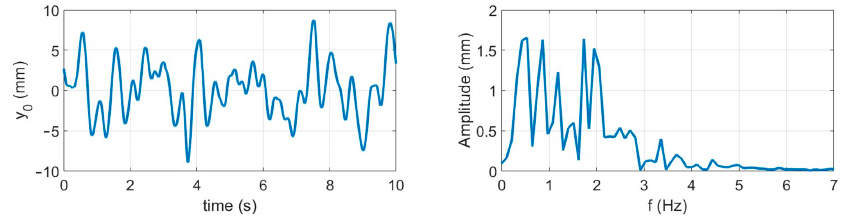
Figure 2. Excitation signal 𝑦 (cid:2868) ( left ) and its FFT analysis ( right